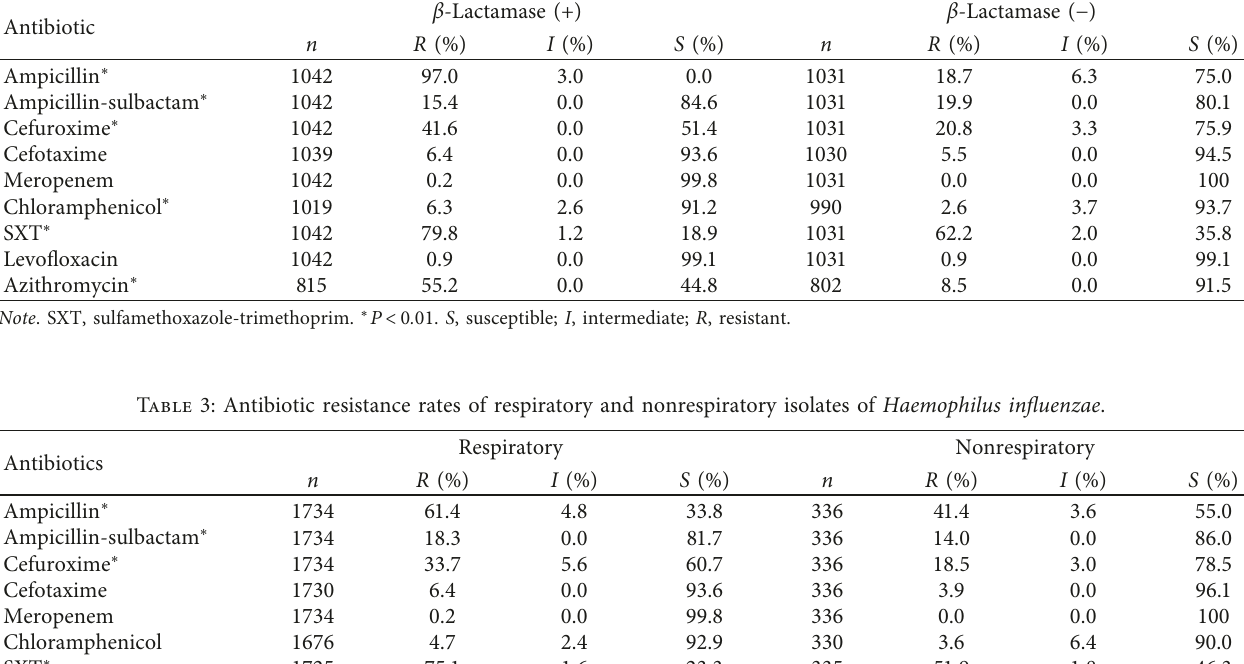
Table 2: Antibiotic resistance rates of β -lactamase-positive and β -lactamase-negative isolates of Haemophilus influenzae . Antibiotic